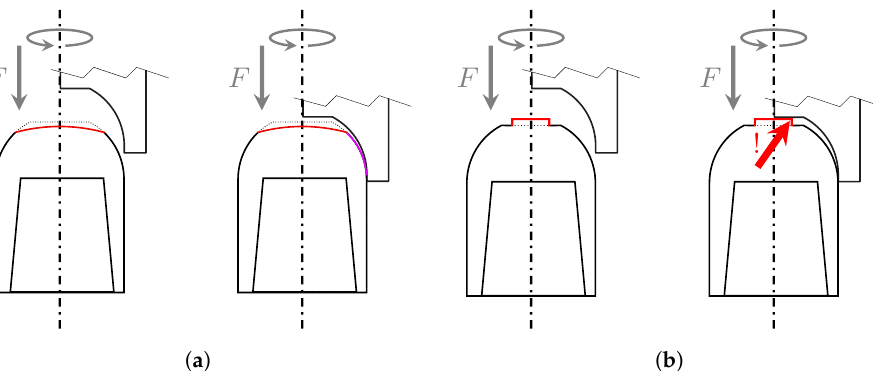
Figure 21. Tip dressing of worn electrodes: ( a ) mushrooming; ( b ) plateau forming.